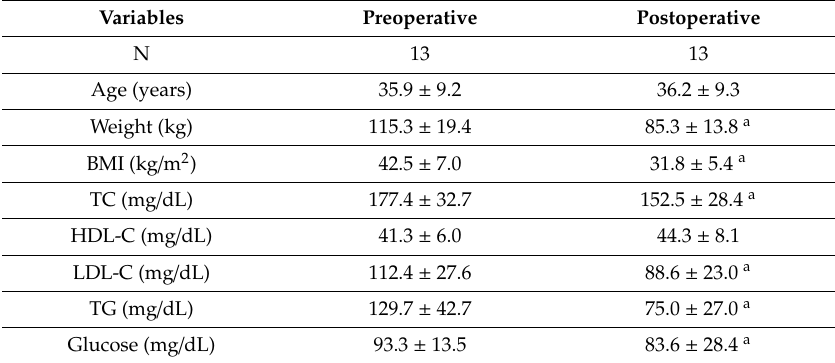
Table 1. Anthropometric data and biochemical profile of obese patients in preoperative and postoperative (six months after Roux-en-Y gastric bypass